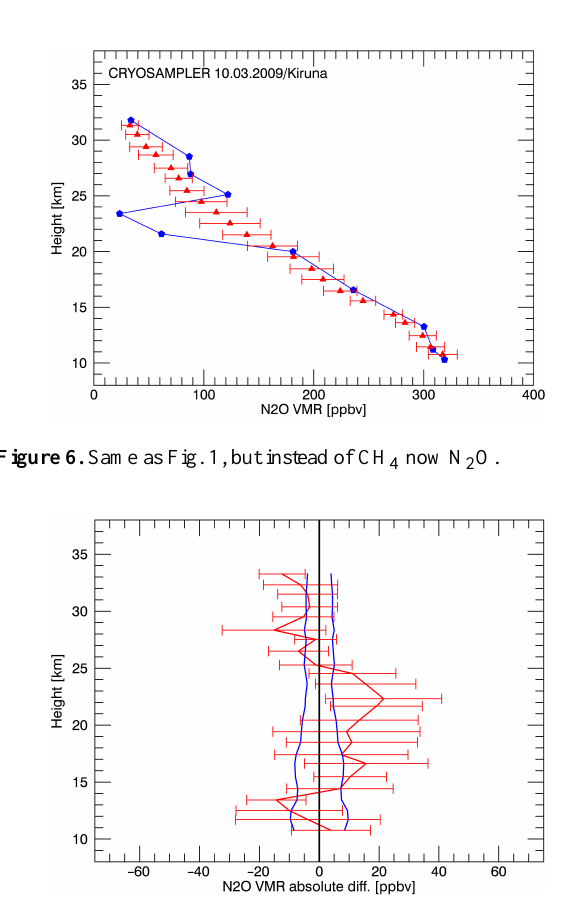
Figure 5. Deviations between MIPAS and cryosampler data after elimination of meteorological feature in profile B45 between 20 and 25km altitude. Left panel: CH 4 validation based on all cryosampler (BONBON) flights considered in this study. Red line: interpolated mean difference between MIPAS-E and cryosampler mixing ratio values. Red error bars: mean standard deviation of the difference between MIPAS-E and cryosampler mixing ratio value for the respective altitude range. Blue line: interpolated mean error for CH 4 mixing ratio values from MIPAS-E database. Right panel: CH 4 validation based on cryosampler flights B42, B43, B45, and B46. Red line: interpolated mean difference between MIPAS-E and cryosampler mixing ratio values. Red error bars: mean standard deviation of the difference between MIPAS-E and cryosampler mixing ratio value for the respective altitude range. Blue line: interpolated mean error for CH 4 mixing ratio values from MIPAS-E database.